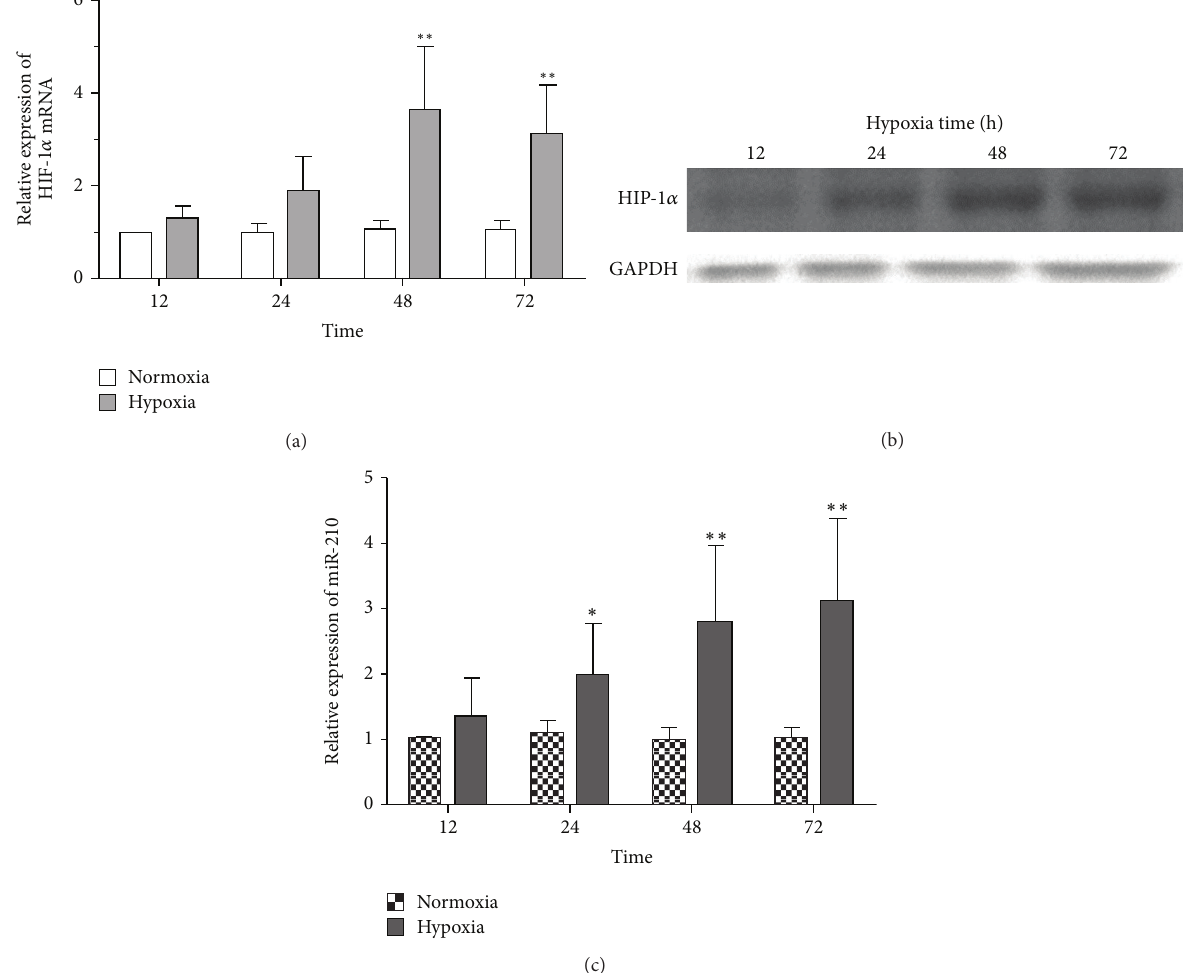
Figure 1: The expression of miR-210 and HIF-1 𝛼 was assayed by qRT-PCR and western plot on hypoxia and normoxia in C28/I2 human chondrocytes. C28/I2 cells were expose to hypoxia or normoxia at 12 h, 24 h, 48h, and 72 h. Then, the HIF-1 𝛼 mRNA was detected by qRT- PCR in cells (a). The expression of miR-210 on hypoxia was contrasted with that on normoxia (c). Expression of HIF-1 𝛼 protein was also confirmed by western plot at 12h, 24 h, 48 h, and 72 h in hypoxic C28/I2 cells (b). Five individual experiments were conducted. Student’s 𝑡 -test was performed to statistically analyzed. The significant differences were denoted as ∗ 𝑃 < 0.05 and ∗∗ 𝑃 < 0.01 . figure legends. All data were expressed as mean ± stan- dard deviation (SD). The SPSS 18.0 was used for general statistical analysis. Comparison among multiple samples was made by ANOVA. Student’s 𝑡 -test was used to compare two groups. 𝑃 < 0.05 was considered to be statistically significant